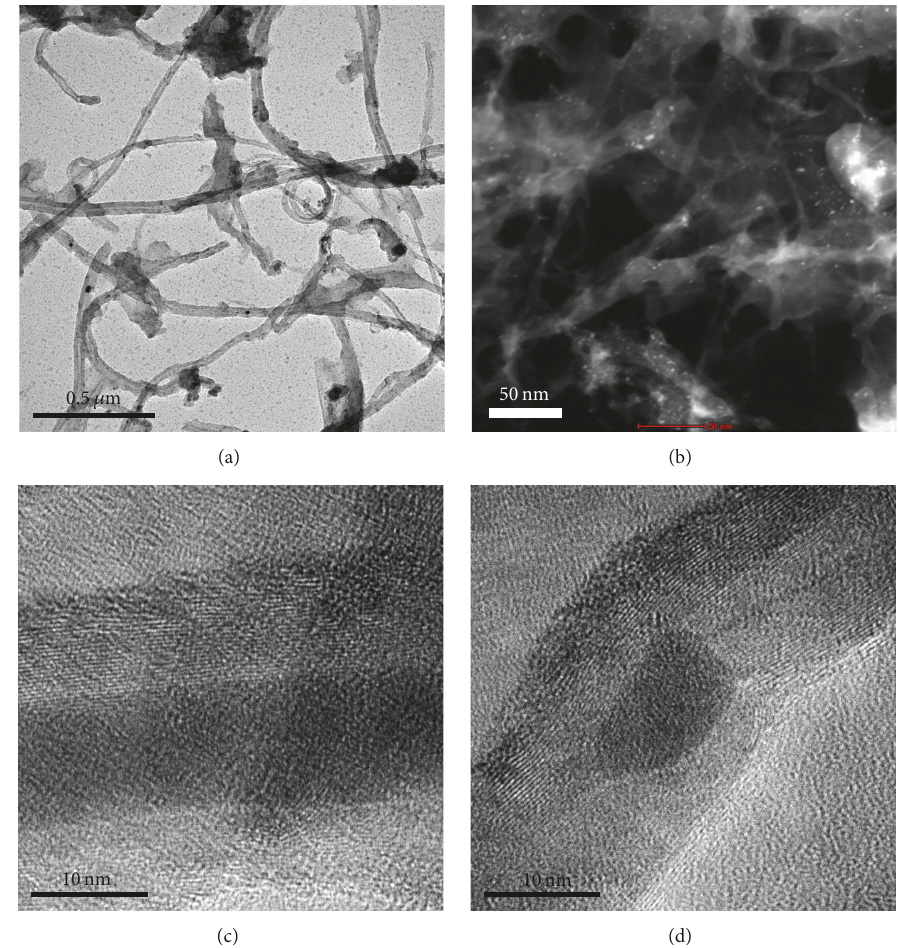
Figure 1: TEM micrographs of the as-synthesized CNTs: (a) bright field image, (b) dark field image, the brightest phase corresponding to residual catalytic particles, (c) HRTEM image showing the presence of MWCNTs, and (d) HRTEM image of the CNTs with Fe particle.